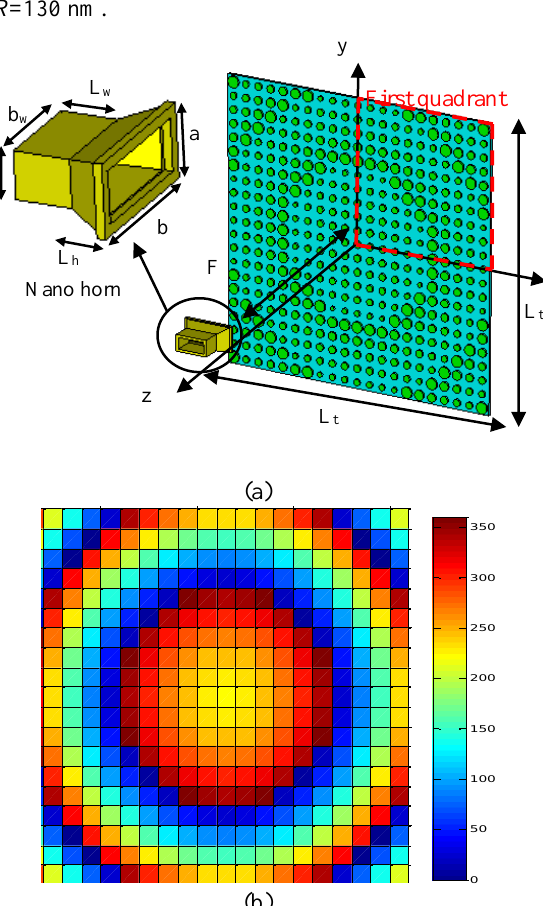
Figure 9. The gain patterns plot for a 21×21 NDRA reflectarray for variable silver supporting plane thickness at 474 THz, L =350 nm, and h d =50